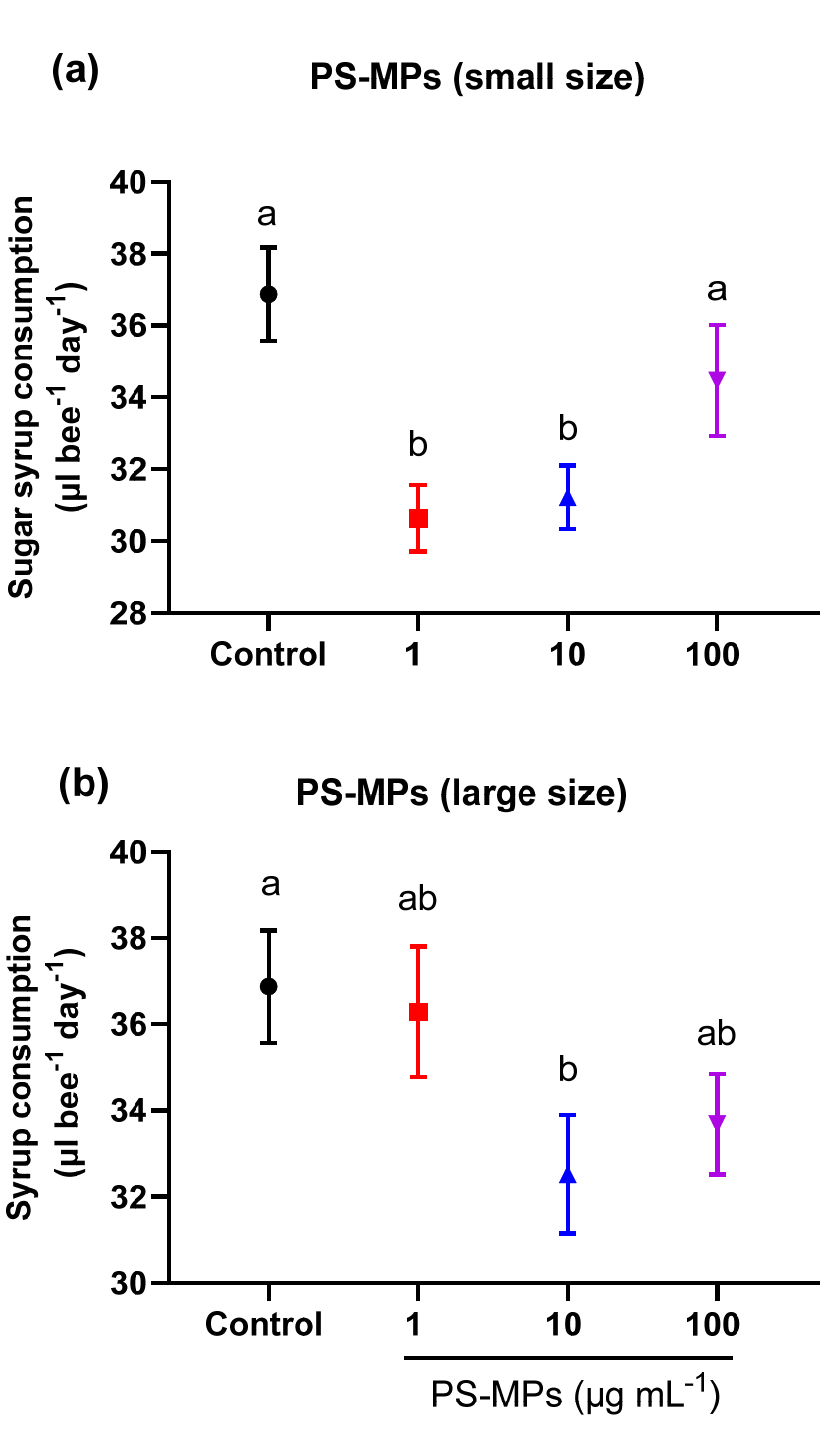
Figure 4. Average sugar syrup consumption (mean ± SEM) of honey bees that were chronically exposed to PS-MP fragments at various concentrations for 14 days. Bees ( n = 35 bees per cage, n = four cages per treatment) were fed ad libitum with various concentrations (1, 10, 100 µ g mL − 1 ) of either ( a ) small sized (27 ± 17 µ m) or ( b ) large sized (93 ± 25 µ m) PS-MP fragments. Controls received the same treatments devoid of PS-MP fragments. Different lowercase letters indicate statistically significant differences between treatments (one-way ANOVA with Tukey’s post hoc test, p < 0.05).